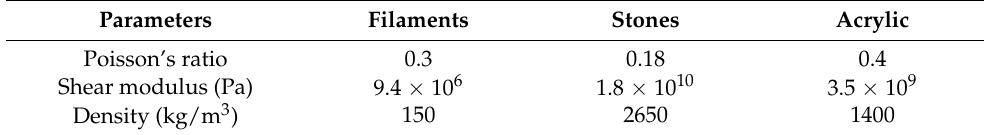
Table 1. Variance analysis of regression model.